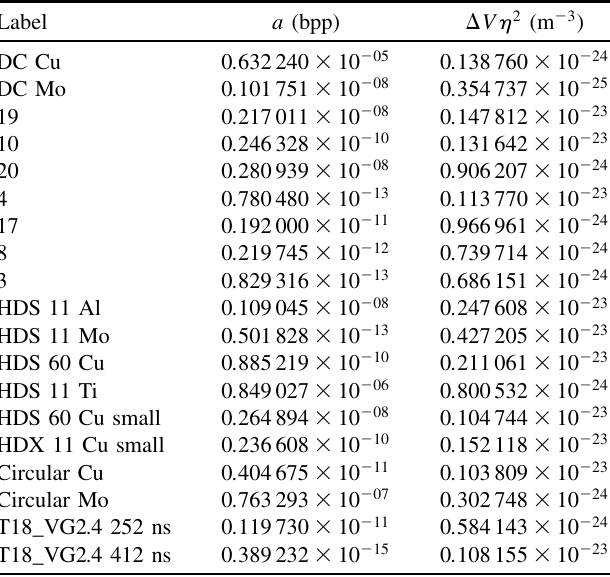
TABLE I. Results from fit. The units of a is breakdowns per pulse (bpp) and for (cid:1) V m (cid:2) 3 . (cid:2) is a unitless factor that gives the ratio between surface field and accelerating gradient (see text) in rf cavities. For the DC experiments (top two entries) (cid:2) ¼ 1 . The labels correspond to the ones in Figs. 1–4.